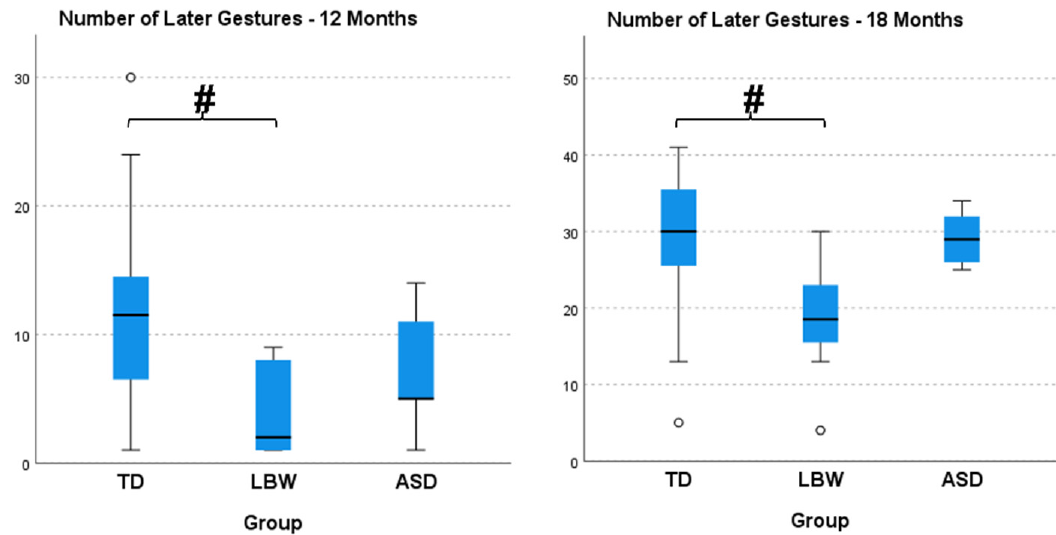
Figure 2. Number of later gestures at 12 and 18 months of age from the MacArthur-Bates Commu- nicative Development Inventories (CDIs). TD, infants with typical development; LBW, infants born prematurely and with low birth weight; ASD, infants with a sibling diagnosed with ASD. The # sign indicates significant differences between groups while the ◦ denotes outliers.